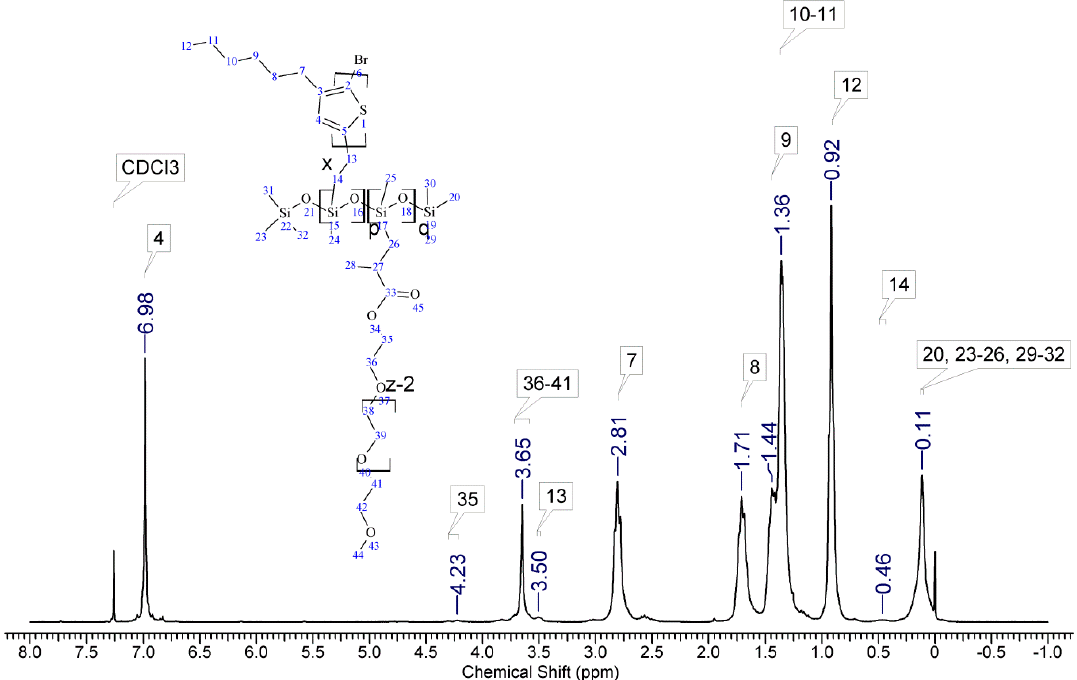
Figure A4. 1 H-NMR spectrum of poly(methylhydrosiloxane)-graft-[poly(3-hexylthiophene); poly(ethylene glycol) methacrylate] (PEG-OH M n ≈ 500) (SilPEG1.4).